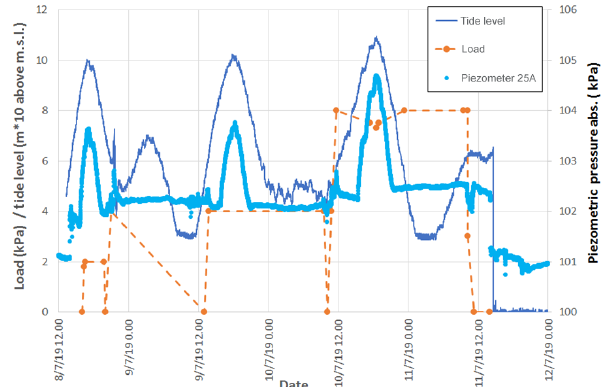
Figure 7. Time behavior of the applied load, tide level and pressure at piezometer 25A, which is 20cm deep and at a distance of 15cm from the load center (Fig. 6). The records cover the whole period of the loading test, i.e. from 8 July at 12:00LT to 11 July at